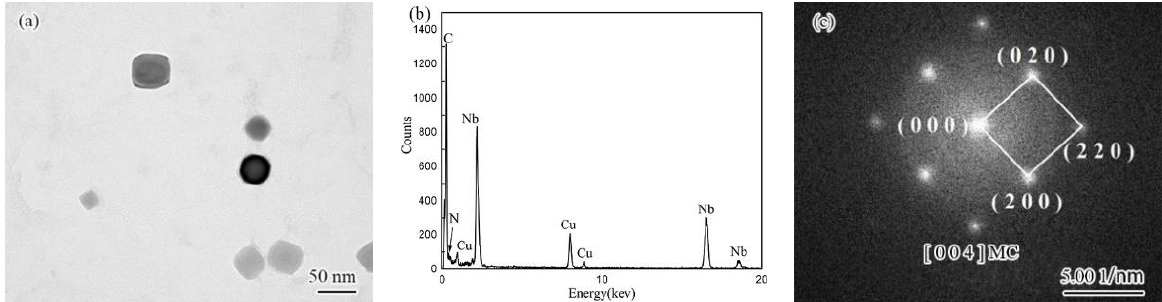
Figure 10. ( a ) TEM image of a MC-type particle precipitated, corresponding ( b ) EDS and its ( c ) FFT result.